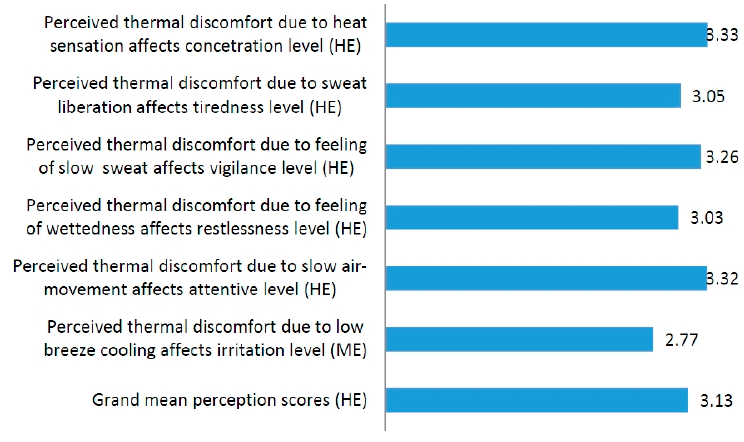
Figure 5. Students’ perceived stress behaviour levels affecting learning in LTH-2.